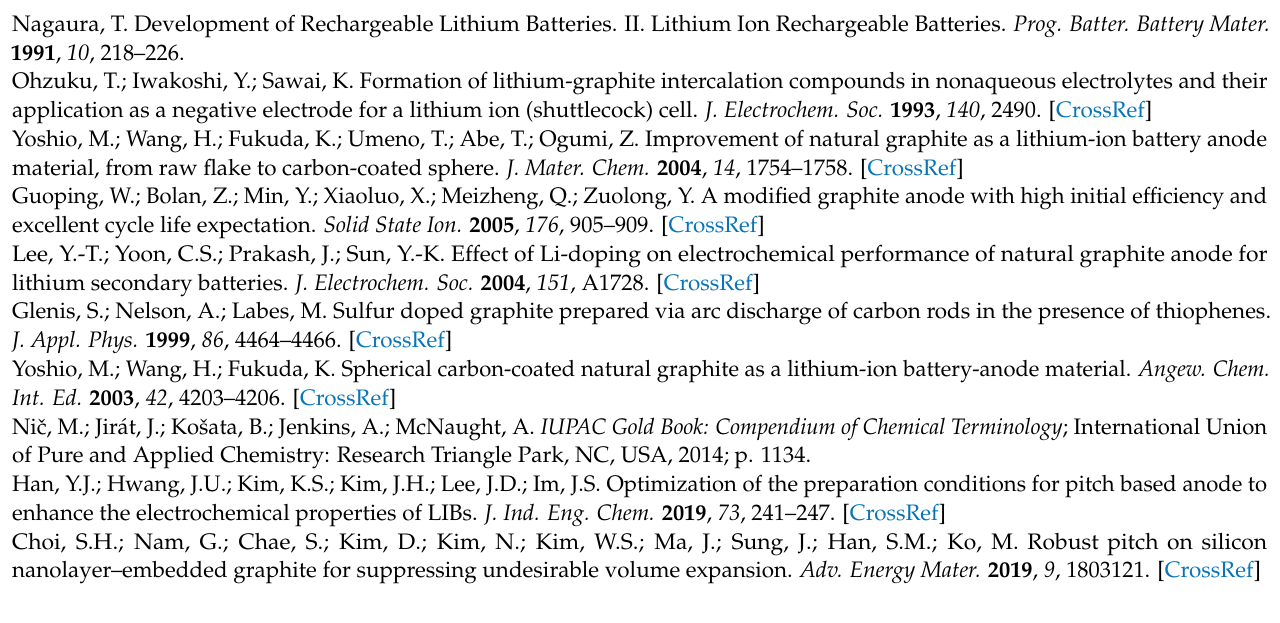
behavior of coating pitch in N2 atmosphere; Figure S2: Sem images of FG and CFG5; Figure S3: XRD of FG and CFG5; Figure S4: Galvanostatic charge/discharge (GDC) of pyrolyzed pitch at the first cycle; Figure S5: Rate performance at various delithiation rates of pyrolyzed pitch and cycling stability; Figure S6: EIS curves after cycling of FG and CFG5; Figure S7: Cyclic voltammograms at different scan rates of (a) FG, (b) CFG5, (c) CFG10, (d) CFG15, and (e) CFG20; Figure S8: Influence of (a) density and (b) electronic conductivity as a load (kgf); Figure S9: Actual density and the calculated density of CFG5 and actual density of FG and pyrolyzed pitch according to the load; Table S3: Actual density and the calculated density according to the